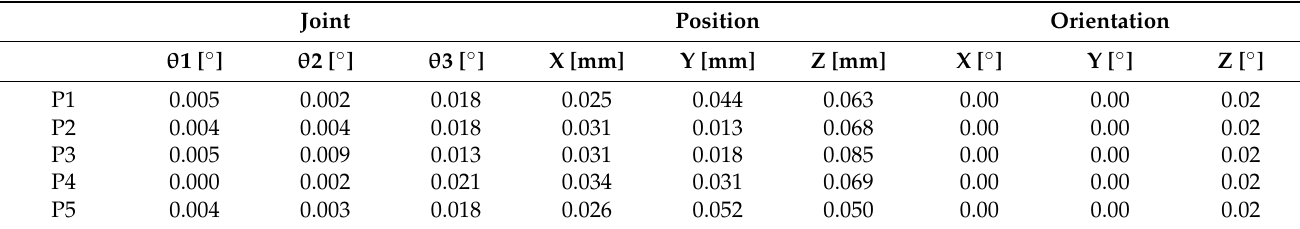
Table 5 represents the deviation of joint angle, position, and orientation from the desired position during the test. Table 5. Standard deviation of joint angle, position, and